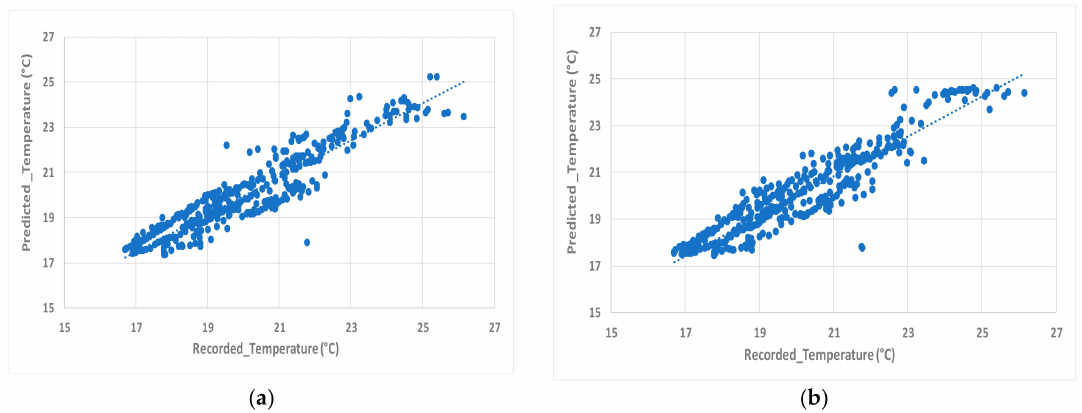
Figure 6. Predicted facade temperature with the recorded facade temperature (input parameter = outdoor temperature): ( a ) prediction for 0.5 h; and ( b ) prediction for 1 h.